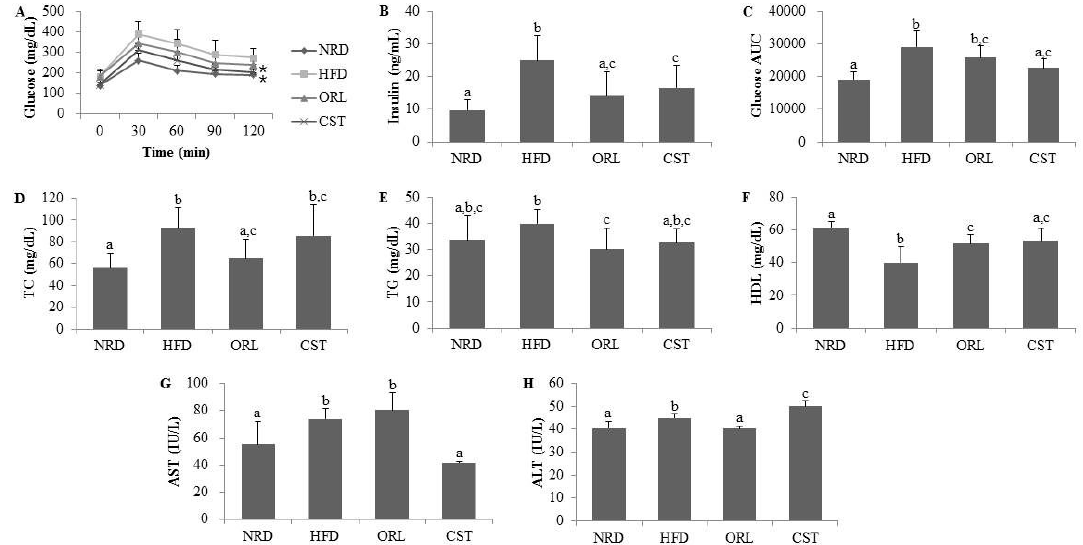
Figure 2. Impact of CST on the glucose tolerance, insulin and other vital metabolic parameters: ( A ) Blood glucose level; ( B ) Insulin level; and ( C ) Area under the curve (AUC) in oral glucose tolerance test (OGTT); ( D ) Total cholesterol (TC); ( E ) Triglyceride (TG); ( F ) High-density lipoprotein (HDL); ( G ) Aspartate transaminase (AST); and ( H ) Alanine transaminase (ALT). Data represented the mean ± SD ( n = 6). Different letters above bars indicate significant difference from each other at p < 0.05 as determined by one-way ANOVA with Least Significant Difference (LSD) post hoc test. * indicates statistical significance compared with HFD group at p < 0.05.